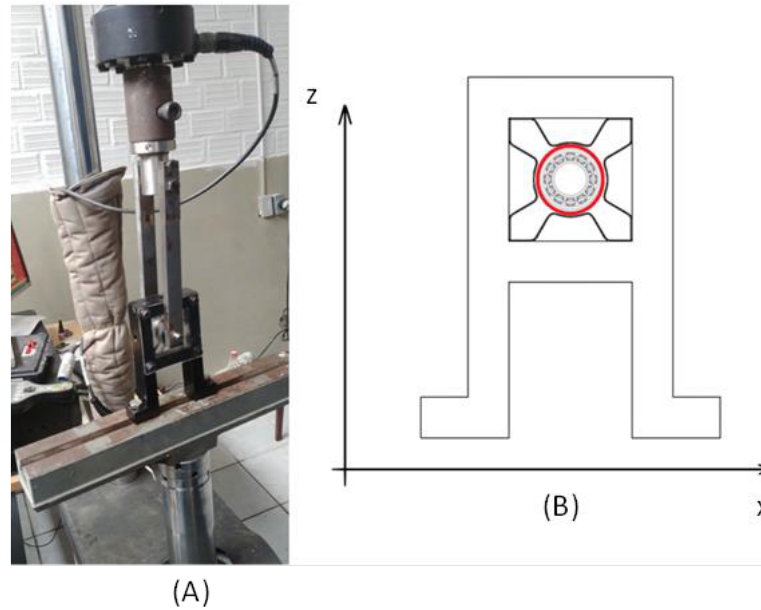
Figure 7. ( A ) Photograph and ( B ) sketch of the dynamic experiment in MTS 810.